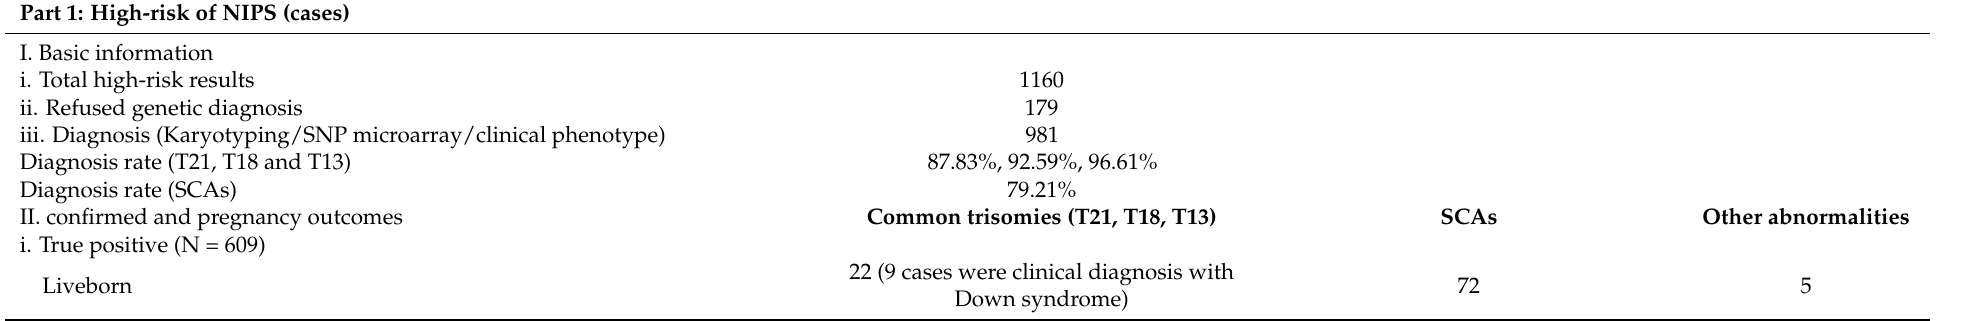
Table A4. Follow-up study in high- and low-risk results of